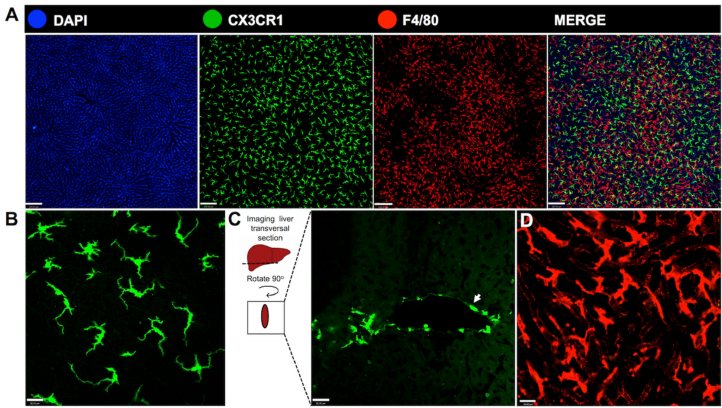
Figure 3. In vivo visualization of distinct morphological aspects of liver phagocytes. ( A ) Intravital imaging of CX3CR1 gfp/wt reporter mice under homeostatic condition revealed large hepatic cell populations with different spatial distribution: CX3CR1 + cells (in green), which is not expressed by liver macrophages and are suggestive of a dendritic cell population, and Kupffer cells stained with anti-F4/80 antibody (in red), merged with DAPI (in blue), a marker for DNA used to identify the nucleus of the cells in the field. Images through the hepatic surface showed that CX3CR1 + cells are abundant and uniformly distributed, unlike Kupffer cells; ( B ) a higher magnification of image showing the dendritic morphology of dendritic cells in the capsule; ( C ) transversal section of frozen tissue evidencing the fluorescence of hepatic parenchyma. There are CX3CR1 + cells around a large vessel (arrow), with a more circular form and less dendrites; ( D ) numerous Kupffer cells within the liver parenchyma, evidenced by a distinct morphology. Scale bars in ( A ), 120 µ m. Scale bars in ( B – D ), 26 µ m. All images were acquired using an inverted Nikon Eclipse Ti coupled to an A1 scanning head with no modifications. All animal studies were approved by the Animal Care and Use Committee at Universidade Federal de Minas Gerais, Brazil (CEUA